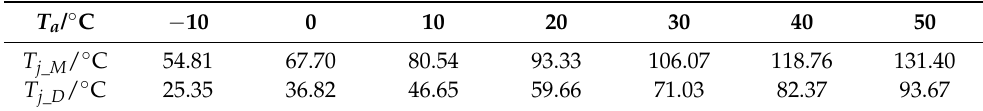
Figure 14. The relationships between junction and ambient temperatures: ( a ) for MOSFET, ( b ) for diode.